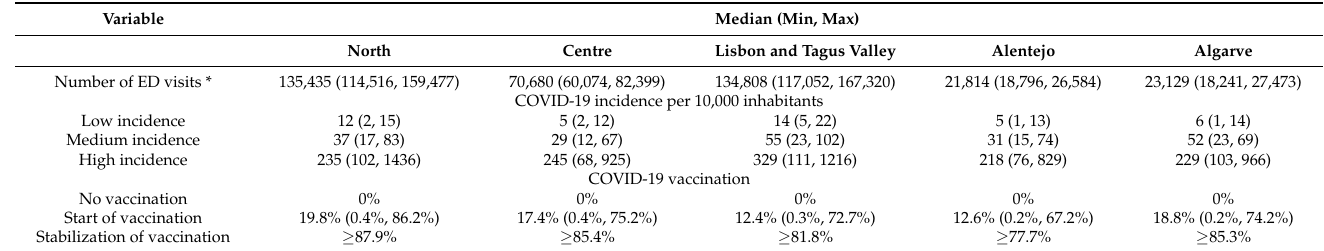
Table 2. Summary of the variables in each region.